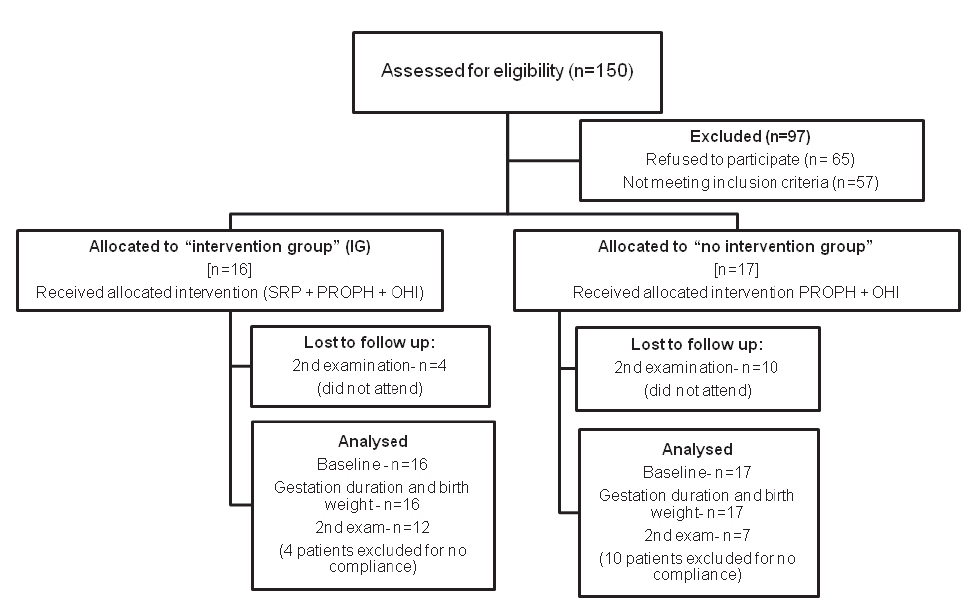
Figure 1- Flow diagram of the progress through the phases of the controlled clinical